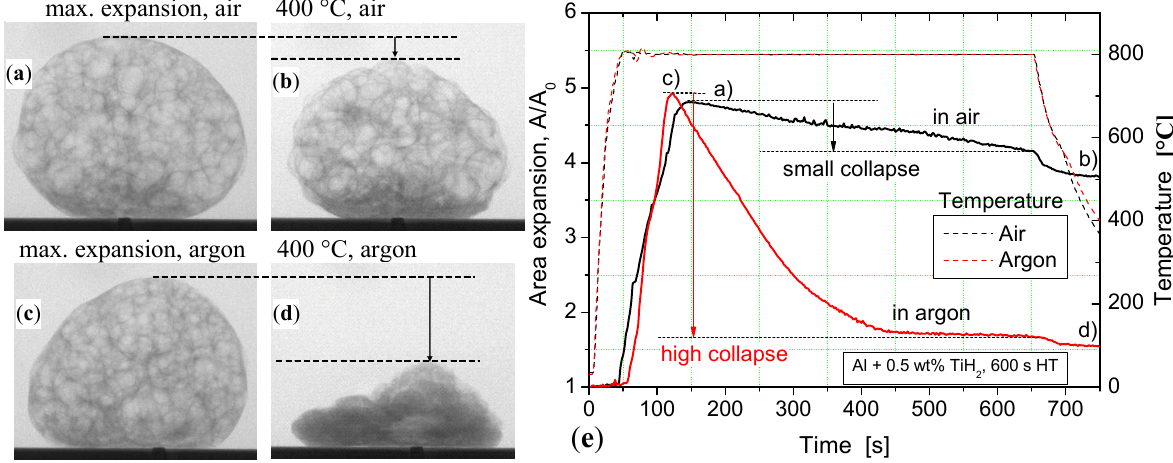
Figure 5. X-ray radiographies of two different Al + 0.5 wt.% TiH ( b ) in air and ( c ); ( d ) in argon at ( a ); ( c ) their maximum expansion and ( b ); ( d ) after cooling down to 400 °C; ( e ) shows the temperature and area expansion courses, indicating the corresponding positions of the radiographies (a), (b), (c) and (d). The holding time is 600